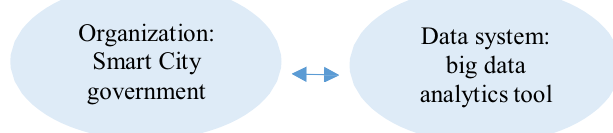
Fig. 1. Smart City and Big Data System